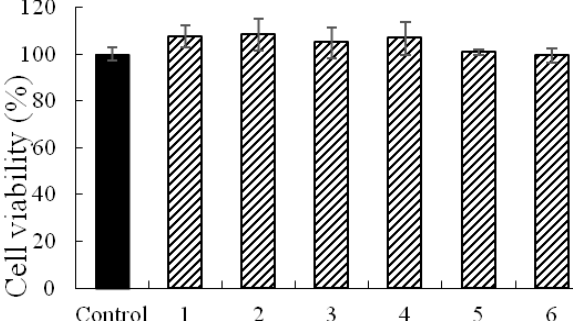
Figure 2. The cell viability of the six alkaloids at 100 μ M on MDCK-pHaMDR cells for 6 h.